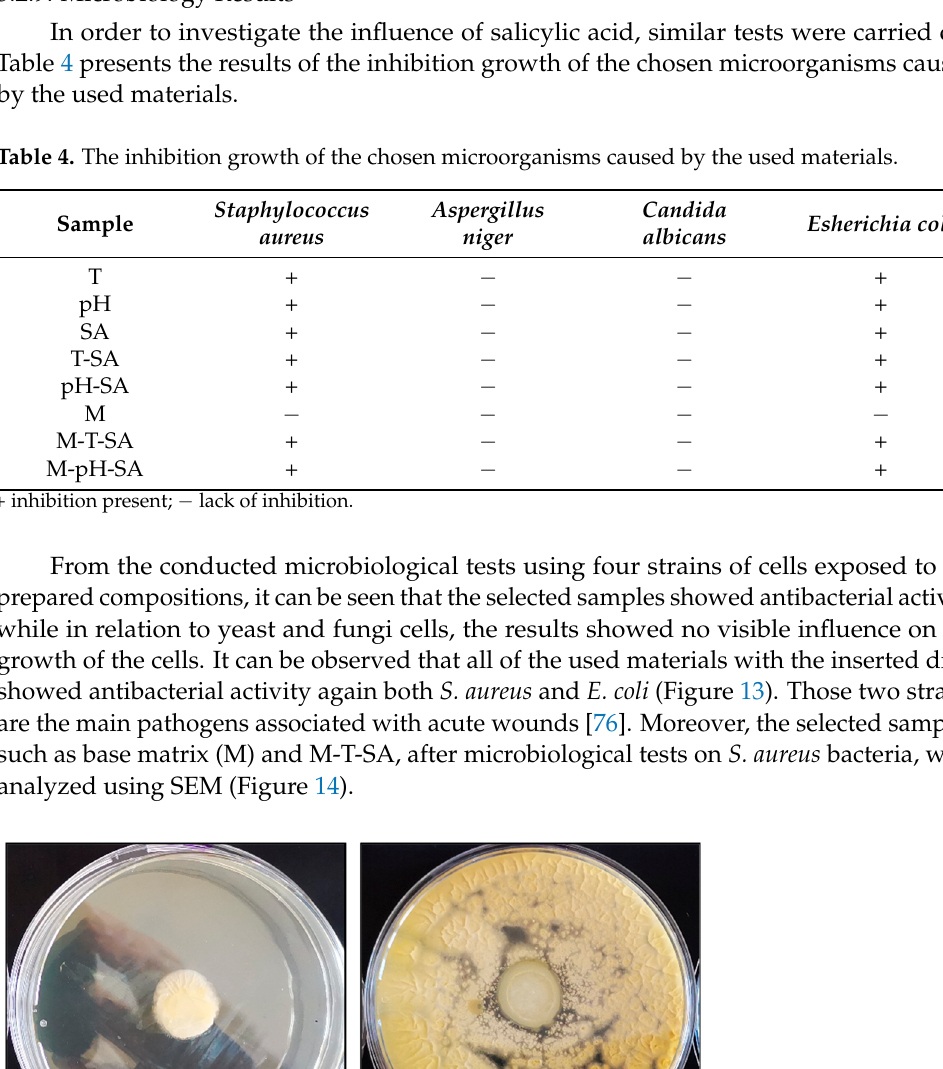
Figure 14. SEM microphotography of bio-hybrid hydrogels: M-T-SA ( A ) and basic matrix (M) ( B ). As can be seen on the right side in Figure 14B of the SEM image, the surface of the base matrix (M) is completely covered with yeast cells, which shows that without the ad- dition of the drug, it has no antimicrobial activity. Additionally, it can be noticed that the S. aureus bacteria appear as spherical and form in grape-like clusters [77]. However, the surface of bio-hybrid hydrogel containing T-SA is clear without any additional bacterial colonies. It confirmed that salicylic acid was released, and it inhibited culture growth. 4. Conclusions To sum up, bio-hybrid hydrogels containing the thermo/pH-sensitive nanocarriers– salicylic acid system (T-SA/pH-SA) were prepared successfully, which was confirmed based on different test results. The average particle size of empty pH- and thermosensitive carriers is about 479 nm and 118 nm, respectively, while after the encapsulation of salicylic acid, these values increase up to 700 and 356 nm for pH-SA and T-SA, respectively. The